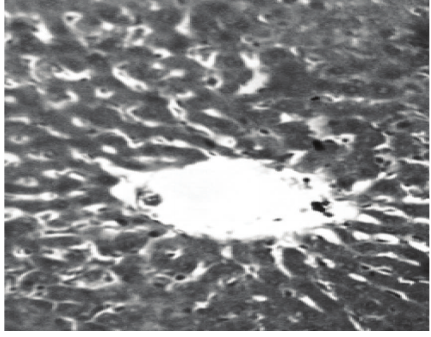
Figure 3: Liver section in AOLE-treated rats showsa normal central vein and blood sinusoids.